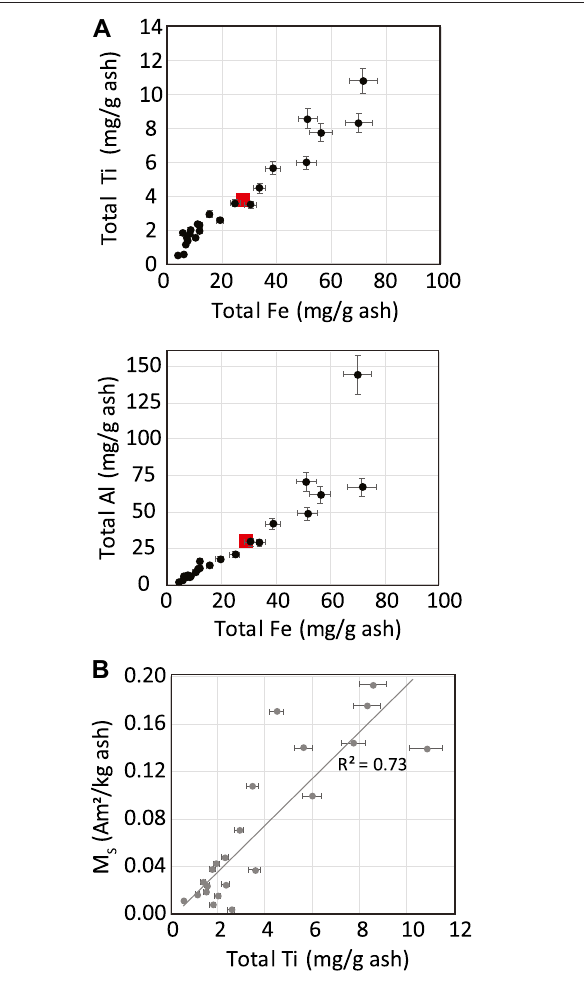
FIGURE 8 | Hysteresis parameters as a function of % mass remaining after burning. (A) Saturation magnetization, (B) coercivity, and (C) ( M R /M s ) of ash and char from different subsets of plant samples. Note that the vertical axis in A is plotted on a logarithmic scale.